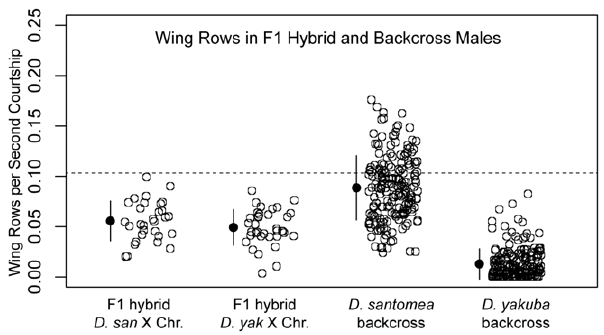
Figure 2. Wing rowing in F1 and backcross hybrid males. y-axis: wing rows normalized to seconds courtship observed in a 15 minute movie. x-axis from left to right: F1 hybrid males from D. santomea females crossed to D. yakuba males; F1 hybrid males from the reciprocal cross; males from an F1 hybrid female backcrossed to a D. santomea male; males from an F1 hybrid female backcrossed to a D. yakuba male. Levels of wing rowing in F1 hybrid males from either cross direction are not significantly different (Student’s t-Test; t=1.3672; D.F.=58.86; p=0.1768; two-tailed) indicating there are no contributing loci on the X chromosome. Filled circles represent the mean level of rowing and lines + / 2 one standard deviation. Dashed line indicates mean wing rowing frequency for the D. santomea parental line from Fig. 1.